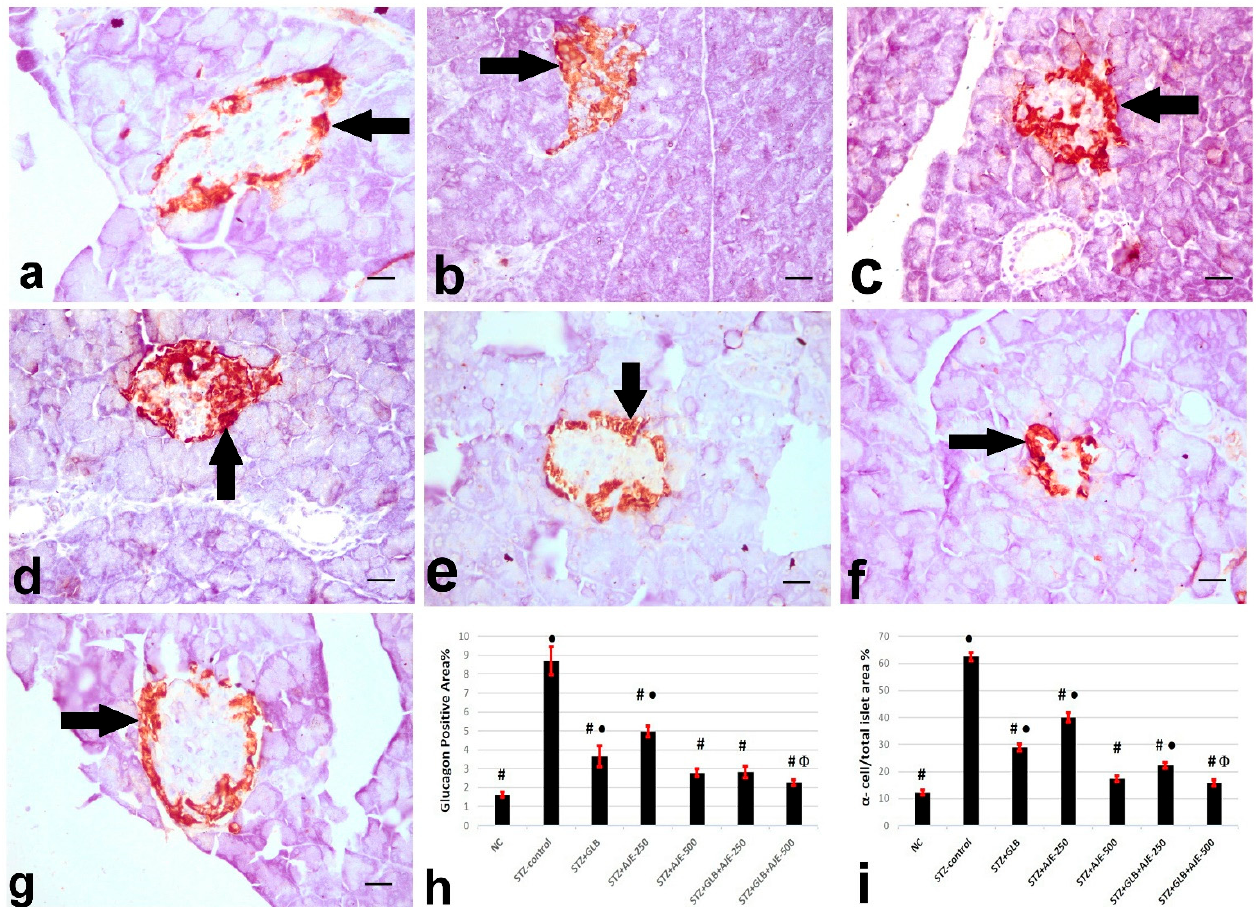
Figure 3. Represented glucagon immunohistochemistry in α -cells (arrows) of the pancreatic islets of the different experi- mental groups: ( a ) NC group, ( b ) STZ-control group, ( c ) STZ + GLB-treated group, ( d ) STZ + AJE-250, ( e ) STZ + AJE-500 group, ( f ) STZ + GLB + AJE-250, and ( g ) STZ + GLB + AJE-500 group; scale bar, 25 µm. ( h ) Bar chart represents the glucagon content of α -cells %. ( i ) α - cell/total islet area %. Data are presented as the mean ± SEM ( n = 7). • Statistically significant difference from the NC group at p ≤ 0.05. # Statistically significant difference from the STZ-control group at p ≤ 0.05. Փ S tatistically significant difference from the GLB group at p ≤ 0.05.